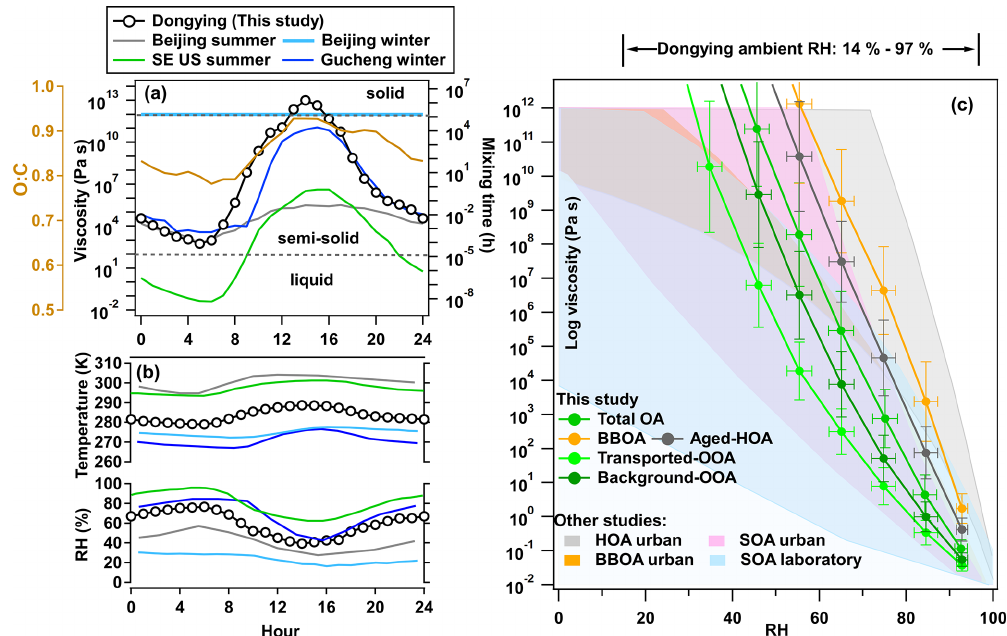
Figure 11. Average diurnal variations of (a) estimated viscosity of total OA, (b) ambient RH, and temperature in different studies. In addition to this study, Beijing and Gucheng reported by Xu et al. (2021) and southeastern United States (SE US) reported by Y. Li et al. (2020) are also shown. The mixing time assuming the particle size is 200nm is displayed on the right axis of panel (a) . (c) Predicted viscosity of total OA, aged-HOA, BBOA, transported-OOA, and background-OOA as a function of RH. The ambient and laboratory viscosity results (Y. Li et al., 2020; DeRieux et al., 2018) are shaded in the background as a